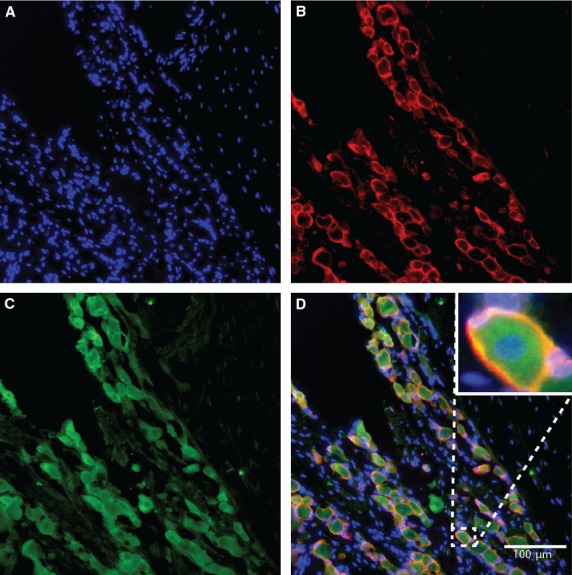
Localization of SNAP-23 in trigeminal satellite glial cells in rat. The blue colour on image (A) represents the nuclear stain Hoechst and stains the nuclei of each cell. SNAP23 positive satellite glial cells were identified by double labelling with antibodies against glutamine synthetase (Red: Alexa fluor® 555), a specific Satellite glial cell marker in ganglia (B) and SNAP-23 (Green: Alexa fluor® 488) (C). On the merged image (D) overlapping of the two colours indicates SNAP23 positive SGCs. The enhanced area on image (D) shows an example of such co-localization of satellite glial cells enveloping a neuron.